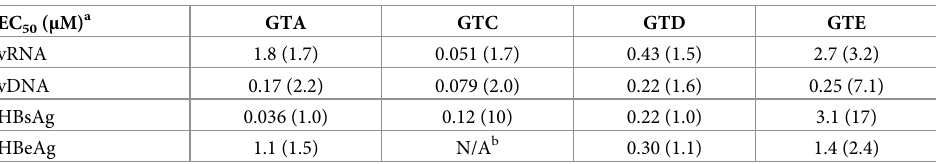
Table 3. Antiviral activity of GS-5801 across HBV genotypes.